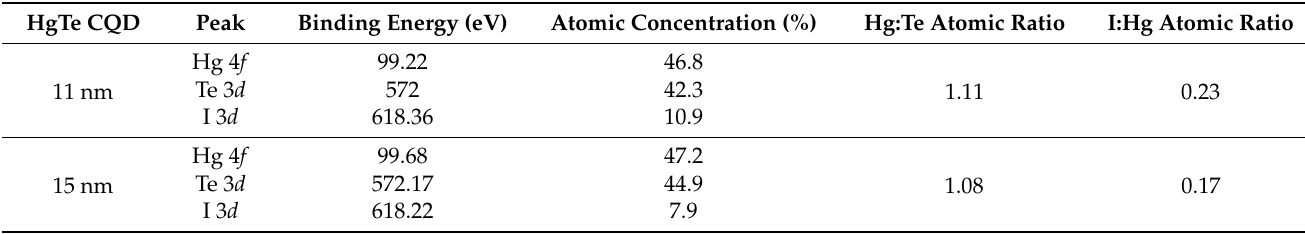
Table 1. XPS results of different HgTe CQDs